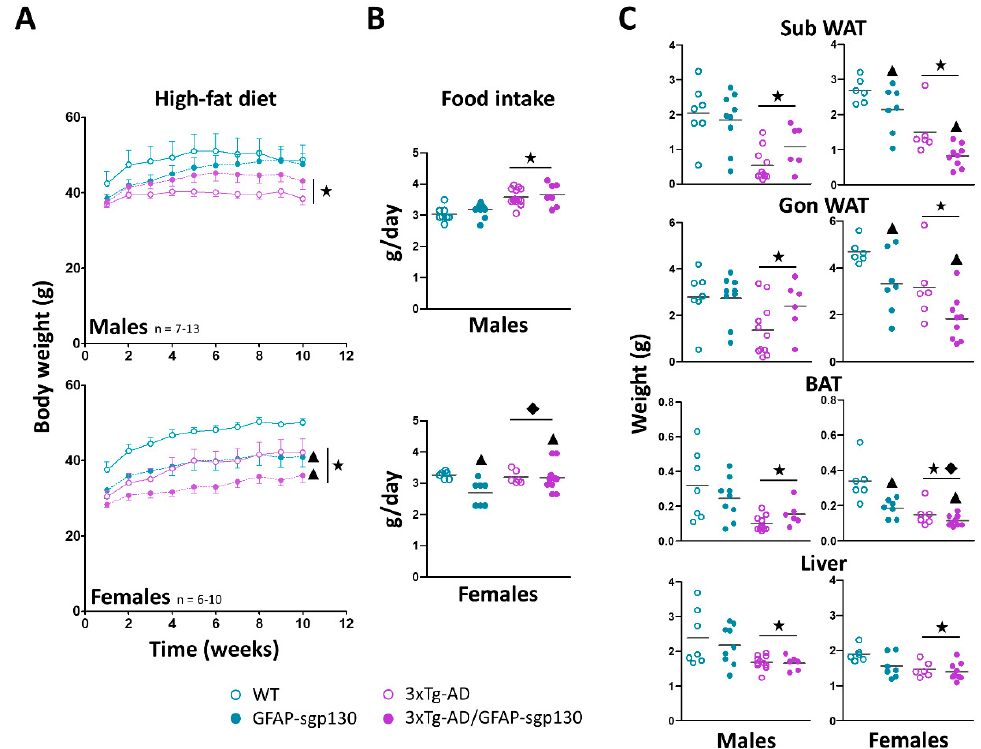
Figure 2. Body weight and food intake alterations in high-fat diet. ( A ) HFD caused obesity, and again 3xTg-AD mice presented lower body weight. The inhibition of IL-6 trans-signaling did not have a significant e ff ect in male mice, whereas in females it decreased HFD-induced obesity of both 3xTg-AD and control mice. ( B ) 3xTg-AD male mice had also higher food intake in this phase. This e ff ect was not observed in females. The inhibition of IL-6 trans-signaling had no e ff ects on males, in females, it decreased food intake, more markedly in the WT than in 3xTg-AD animals. ( C ) The absolute weight from the adipose tissue depots and liver was diminished in 3xTg-AD mice. The blocking of IL-6 trans-signaling further diminished the absolute tissue weights in females. Results are MEAN ± SEM. ★ p ≤ 0.05 vs. 3xTg-AD negative ; ▲ p ≤ 0.05 vs. sgp130Fc negative; ◆ Indicates a significant interaction between both factors.